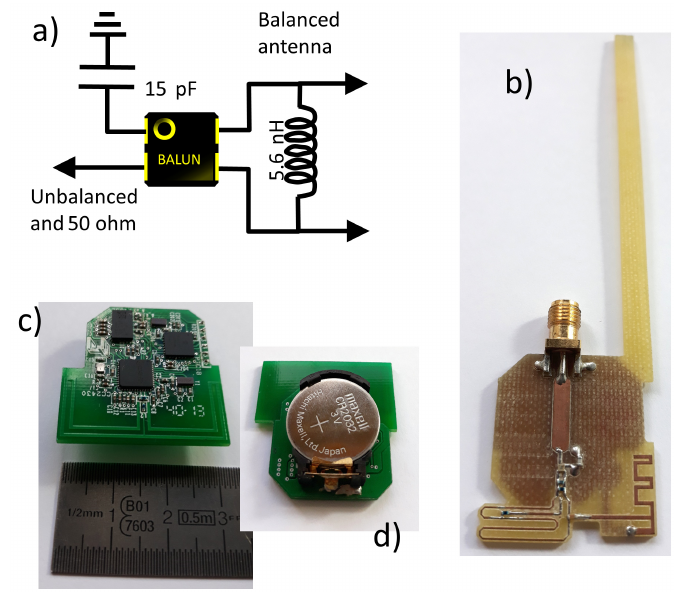
Figure 5. ( a ) Impedance network and balun for P1 prototypes; ( b ) Example of implementation of a prototype P1 of the MIFA m antenna; ( c ) Example of implementation of a prototype P2 of the OFD antenna (TOP VIEW); ( d ) BOTTOM